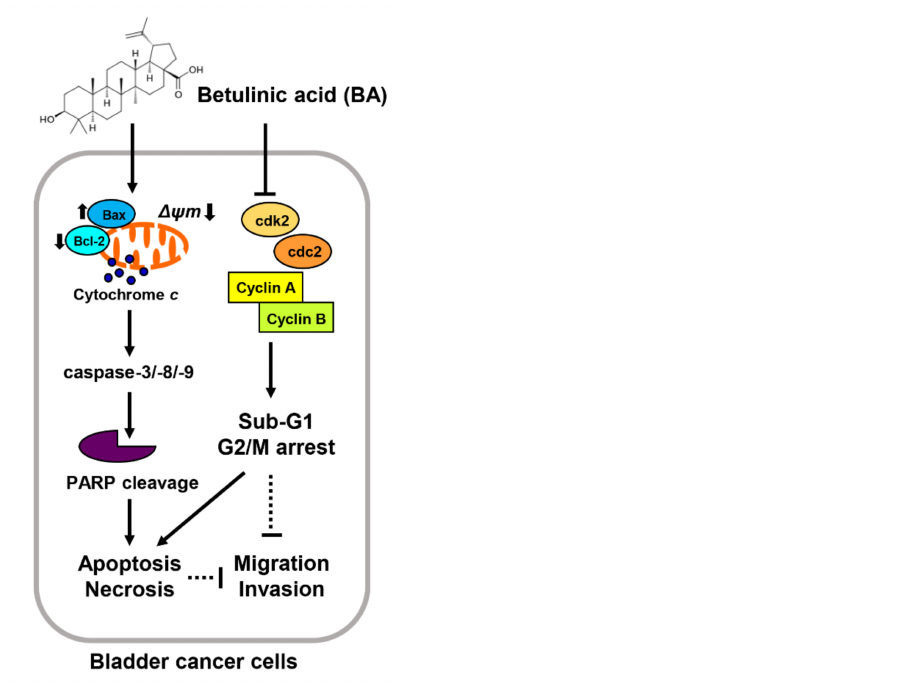
Figure 8. Proposed mechanism of cell proliferation effects of BA in human bladder cancer cells. BA induces apoptosis and necrosis, as well as delay of cell cycle at G2/M phase although it may differ slightly depending on the cell lines. Furthermore, BA results in mitochondrial dysfunction caused by MMP ( ∆Ψ m ) loss, which causes activation of mitochondrial-related intrinsic apoptosis regulators including Bax, caspases, and PARP cleavage. In addition, BA-induced apoptosis is regulated caspase dependently, but ROS independently in bladder cancer cells. Moreover, BA decreases migration and invasion abilities in bladder cancer